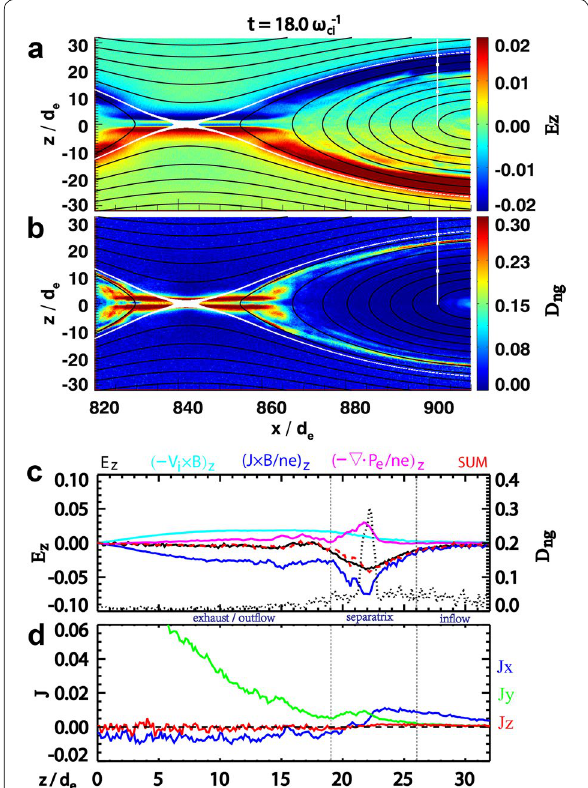
Fig. 1 Simulation results of the magnetic reconnection separatrix region. a , b color contours for E z and local degree of nongyrotropy ( D ng ). The z -axis is perpendicular to the current sheet, x -axis is along the background magnetic field, and y -axis is in the out-of-plane direc- tion to complete the right-handed orthogonal coordinate system. White thick curve lines represent the separatrix field lines. Black curves are in-plane magnetic field lines ( A y contours). B x is positive for z > 0. Hall field E z and D ng are enhances in separatrix layers. c Terms in generalized Ohm’s law at the intercepts of x 902 d e . Red dashed lines = denote the ‘SUM’ of − ( V i × B ) z , ( J × B / ne ) z , and − ( ∇ · P e / ne ) z . Black dotted lines plot the D ng . d The three components of the current